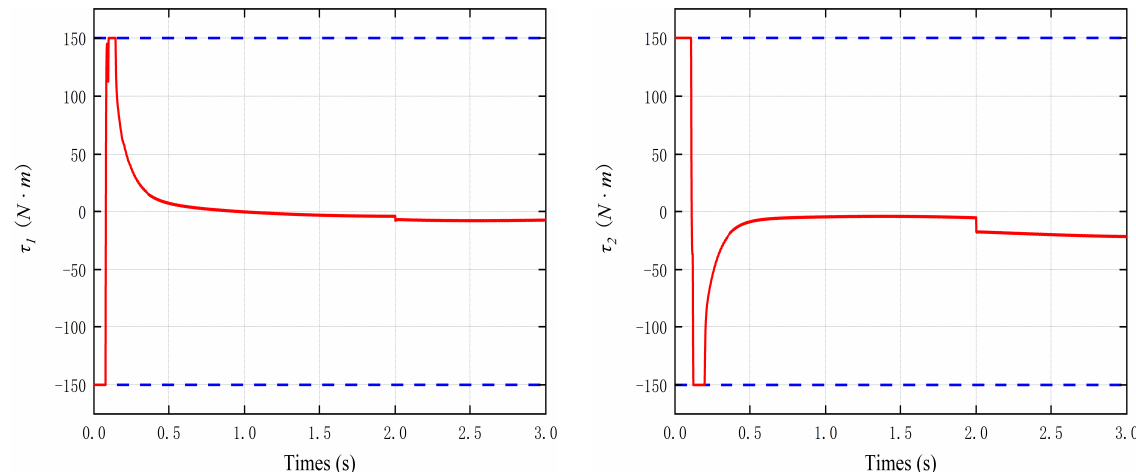
Figure 6. Position tracking error and velocity tracking error of Joint 1 and Joint 2.